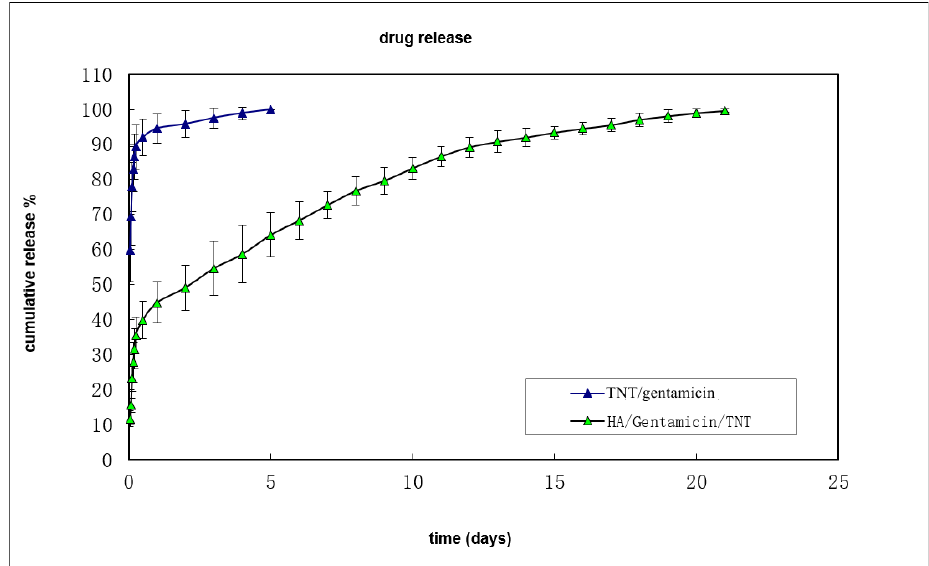
Figure 3. The drug release kinetics of the TNT/Gentamicin and HA/Gentamicin/TNT. Data = mean ± SD, N = 3.